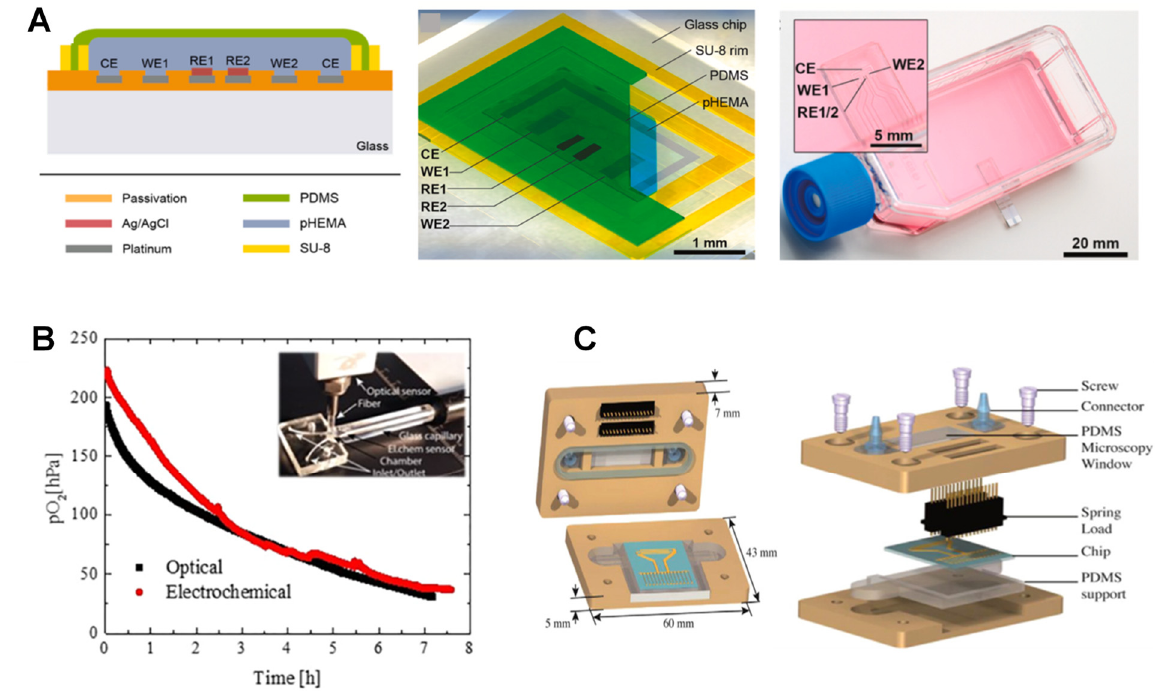
Figure 4. Electrochemical sensors for on-chip O 2 measurement. ( A ) cross-section and top view of the Clark-type O 2 monitoring microsensor via chronoamperometric sensing protocols in cell culture and organ-on-chip systems. Reproduced with permission [85], copyright 2020, Elsevier. ( B ) microfluidic cell culture chip with intra-channel parallel electrochemical and optical O 2 measurement using commercial optical and electrochemical readout devices showing agreement between the results (red and black curves). Reproduced with permission [105], copyright 2019, American Chemical Society. ( C ) Components and cross-section of the microfluidic chip with electrochemical detection electrode arrays for a distinct set of three-electrode for O 2 and the electrode array for Na + , K + and pH measurement. Reproduced with permission [106] , copyright 2015, Elsevier.